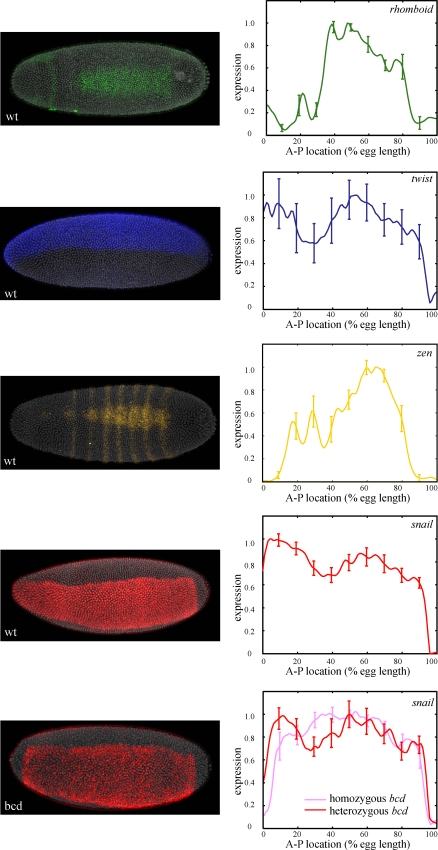
The mRNA Expression Patterns of Dorsal–Ventral Regulatory Factors Are Controlled by Anterior–Posterior FactorsData for wild-type embryos (top four rows) and embryos derived from bcd heterozygous and homozygous mothers (bottom row) are shown. Left panels show the mRNA expression patterns of representative embryos stained for rho, twi, zen, and sna. Dorsal views are shown for sna and twi and ventral views for zen and rho. Right panels show the mean mRNA expression for each gene along the A-P axis for a narrow strip of cells on either the dorsal or ventral midline. The error bars give the 95% confidence intervals for the means. The data for rho expression were derived from n = 22 wild-type (wt) embryos, twist from n = 14 wild-type embryos, zen from n = 10 wild-type embryos, and sna from n = 45 wild-type embryos, n = 24 embryos derived from bcd heterozygous mothers, and n = 24 embryos derived from bcd homozygous mothers.